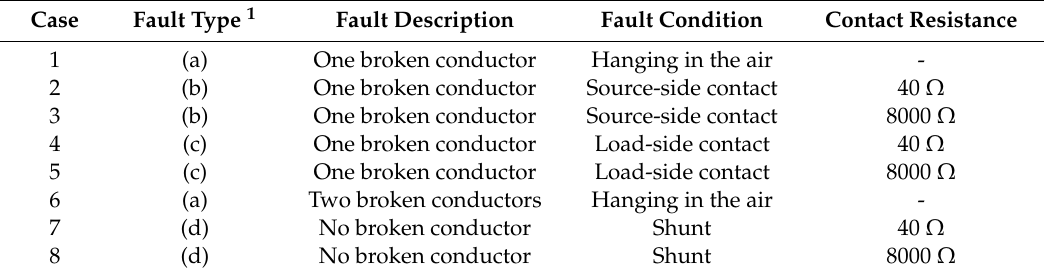
Table 4. Simulated